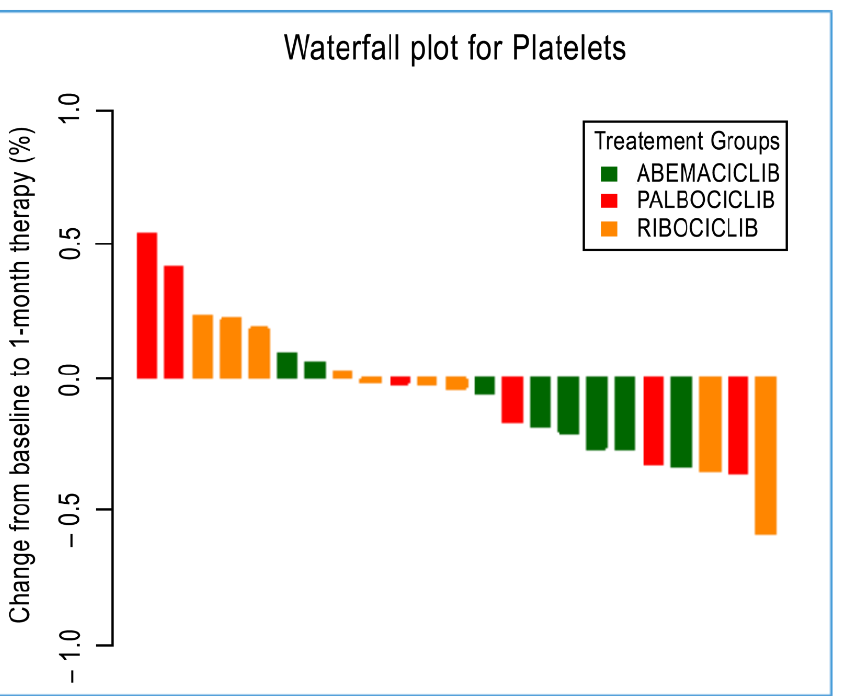
Figure 2. A waterfall plot of post-treatment changes in platelets from baseline for 23 patients. Radiometabolic response at baseline and after 28 days (28 days of continuous treatment for abemaciclib, 21 days of treatment and one week off for palbociclib and ribociclib).